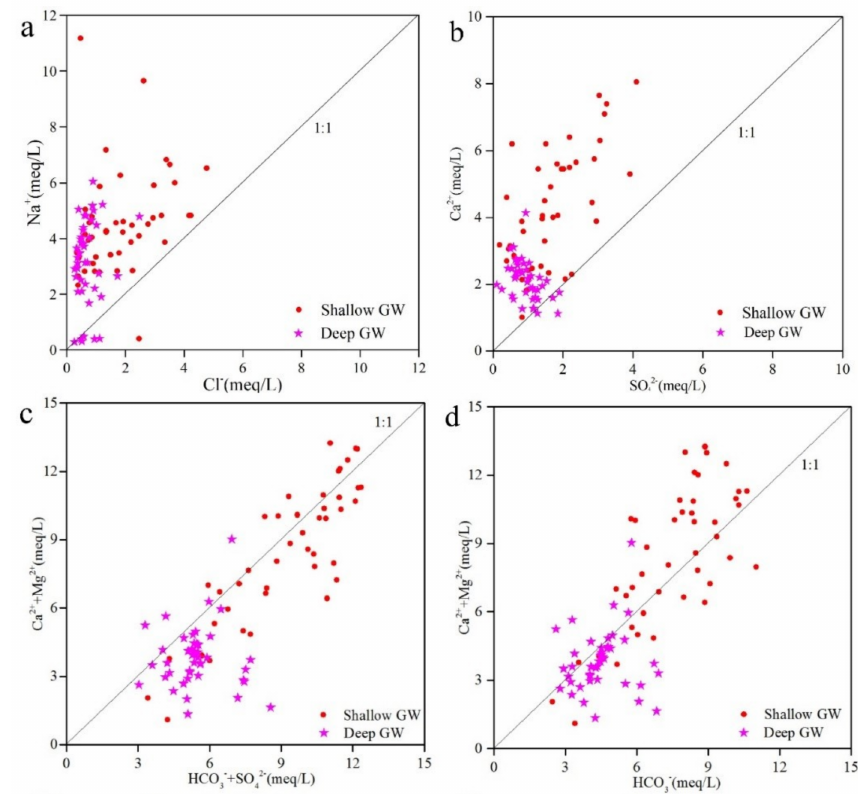
Figure 5. Bivariate plot of different ions showing the correlation of major ions to discriminate the chemical processes. ( a ) Na + vs. Cl − , ( b ) Ca 2+ vs. SO 42 − , ( c ) (Ca 2+ + Mg 2+ ) vs. (HCO 3 − + SO 42 − ), ( d ) (Ca 2+ + Mg 2+ ) vs. HCO 3 −